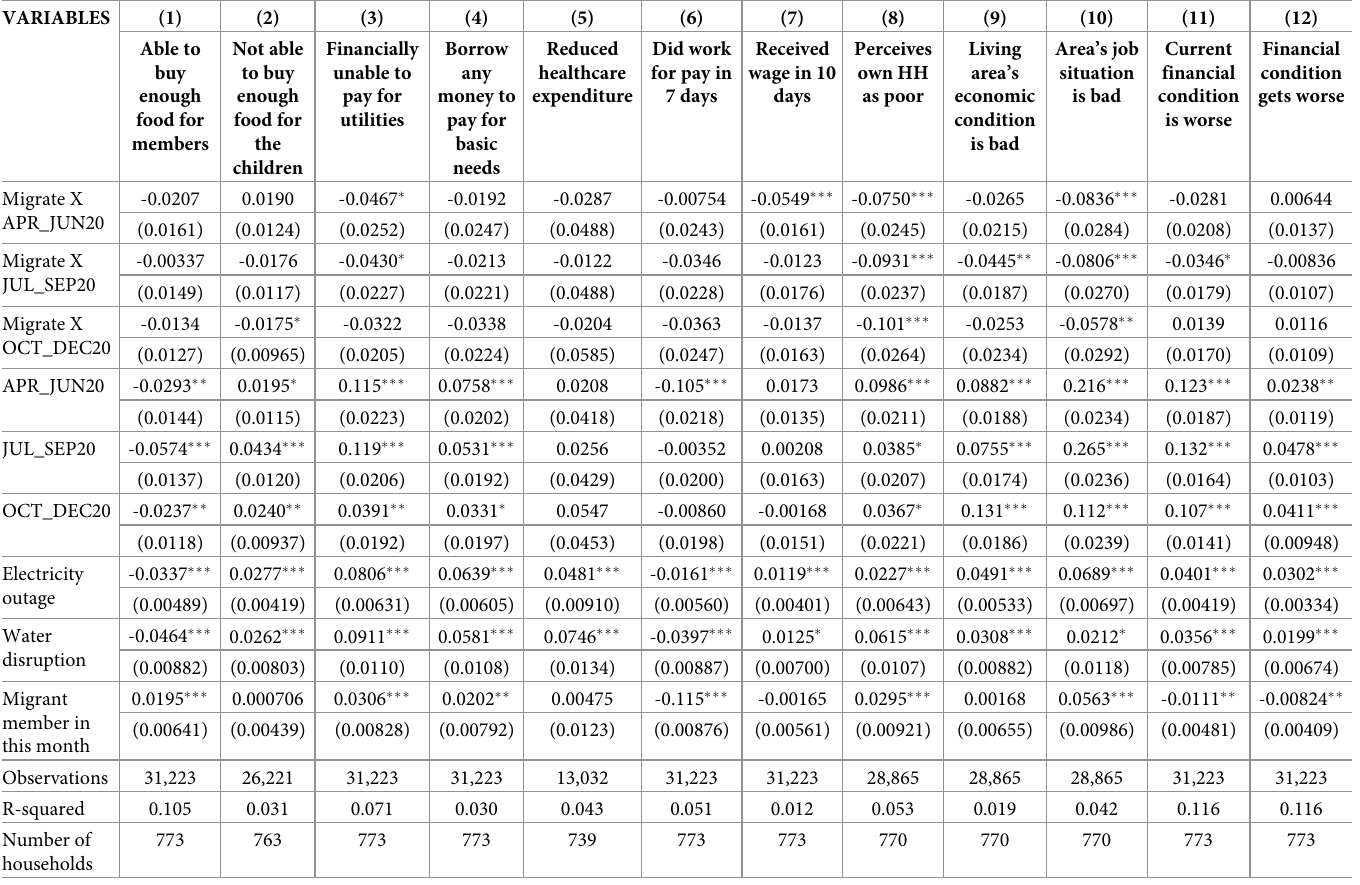
Table 3. Impact of migration on household welfare during the with-COVID-19